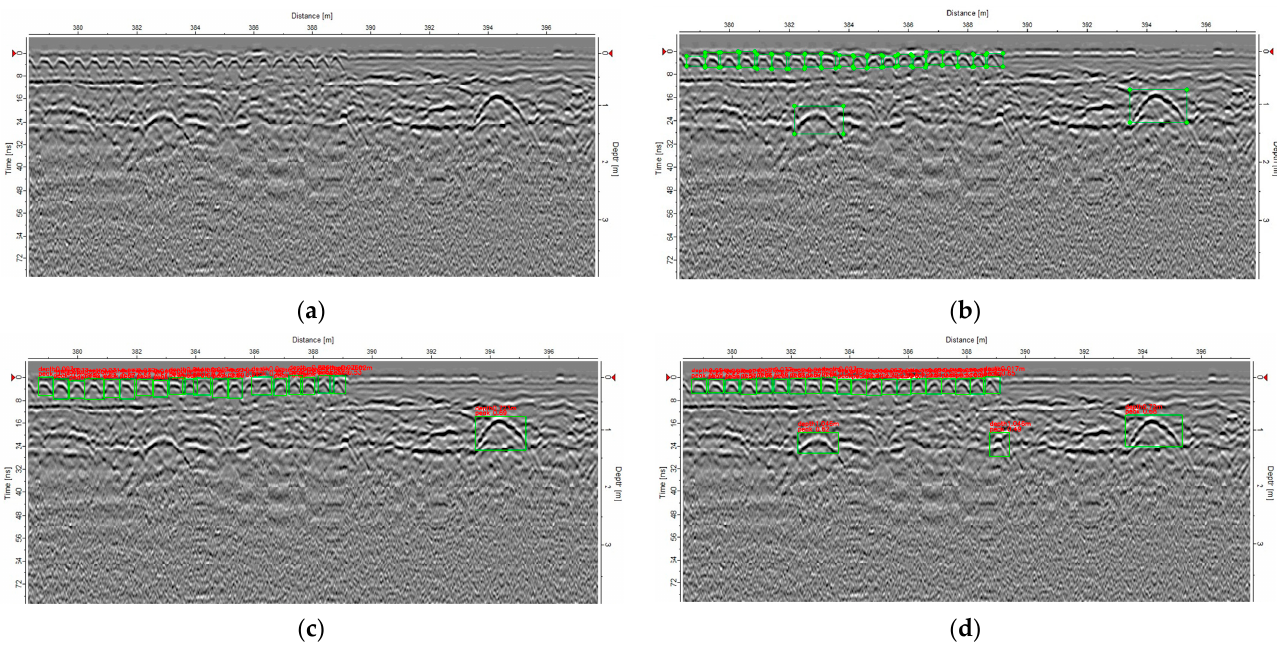
Figure 26. ( a ) Original image; ( b ) foreign objects expected to be detected; ( c ) foreign objects detected by the YOLOv5 algorithm; ( d ) foreign objects detected by the improved YOLOv5 algorithm.